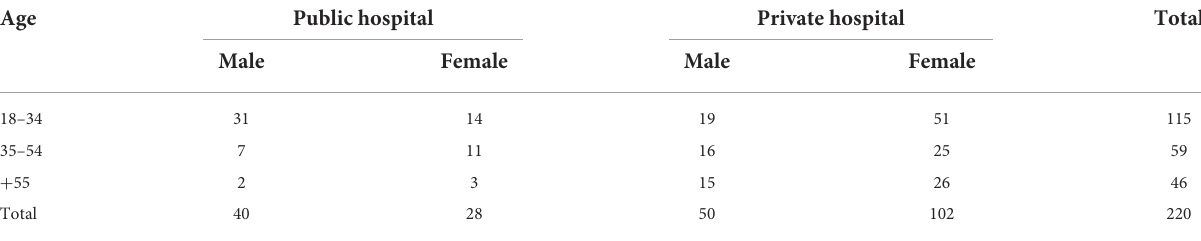
TABLE 1 Distribution of the surveyed visitors according to age, gender, and hospital type.